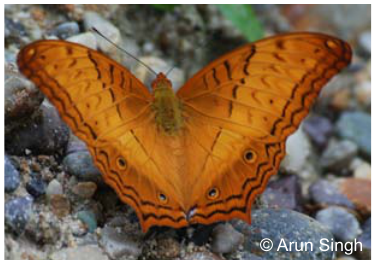
Image 38. Cruiser Vindula erota Image 40. Black Vein Sergeant